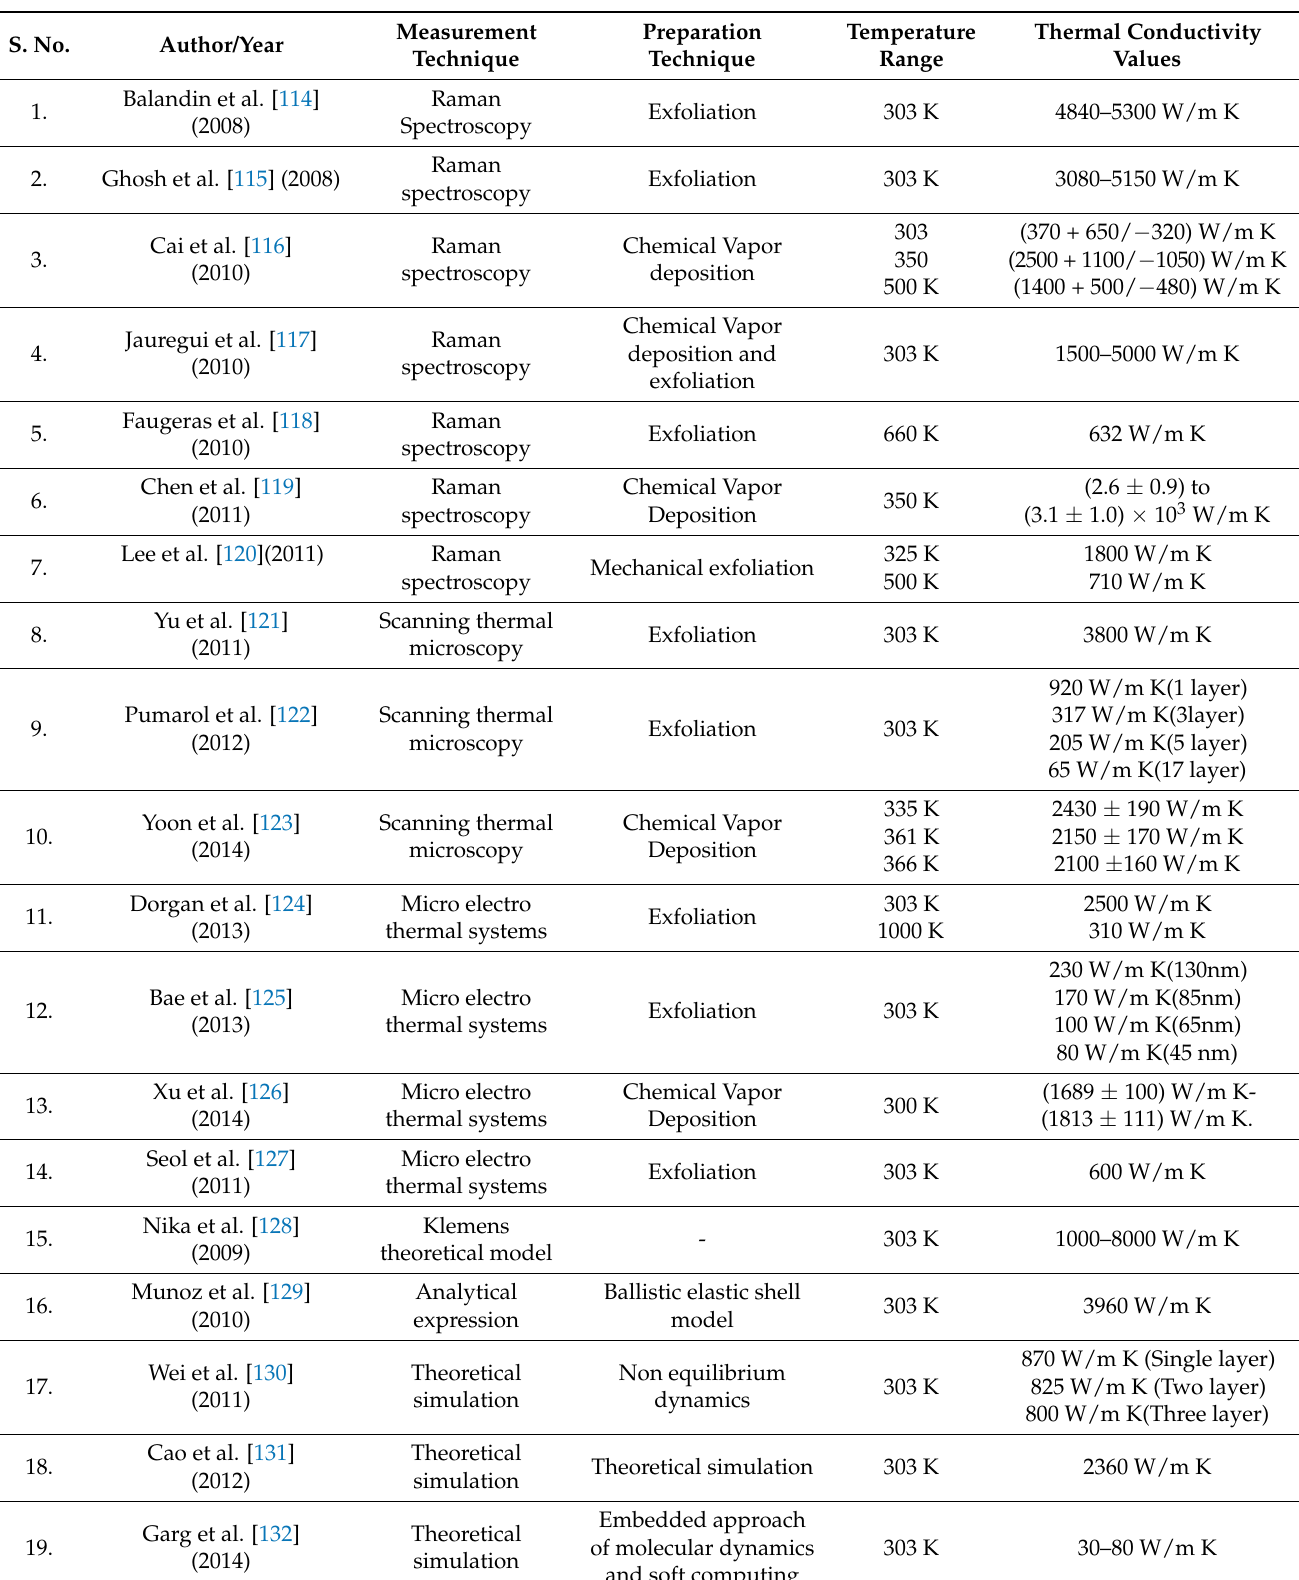
Table 3. Summary of published literature on thermal conductivity of